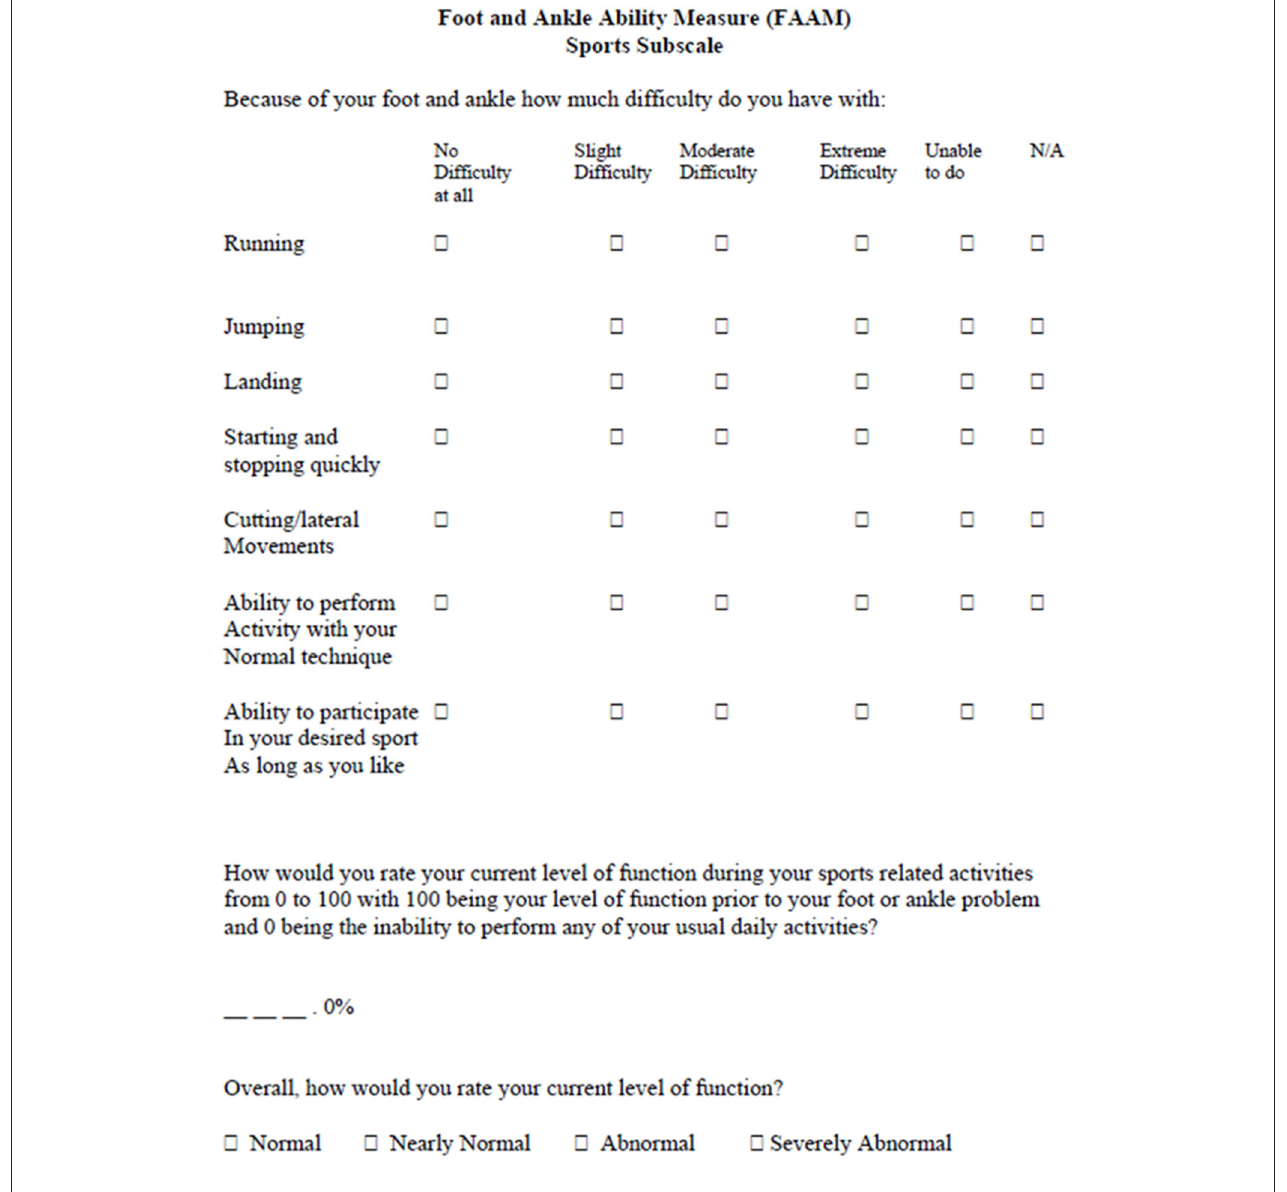
FIGURE 6 | Foot and ankle ability measure, sports subscale (FAAM sport